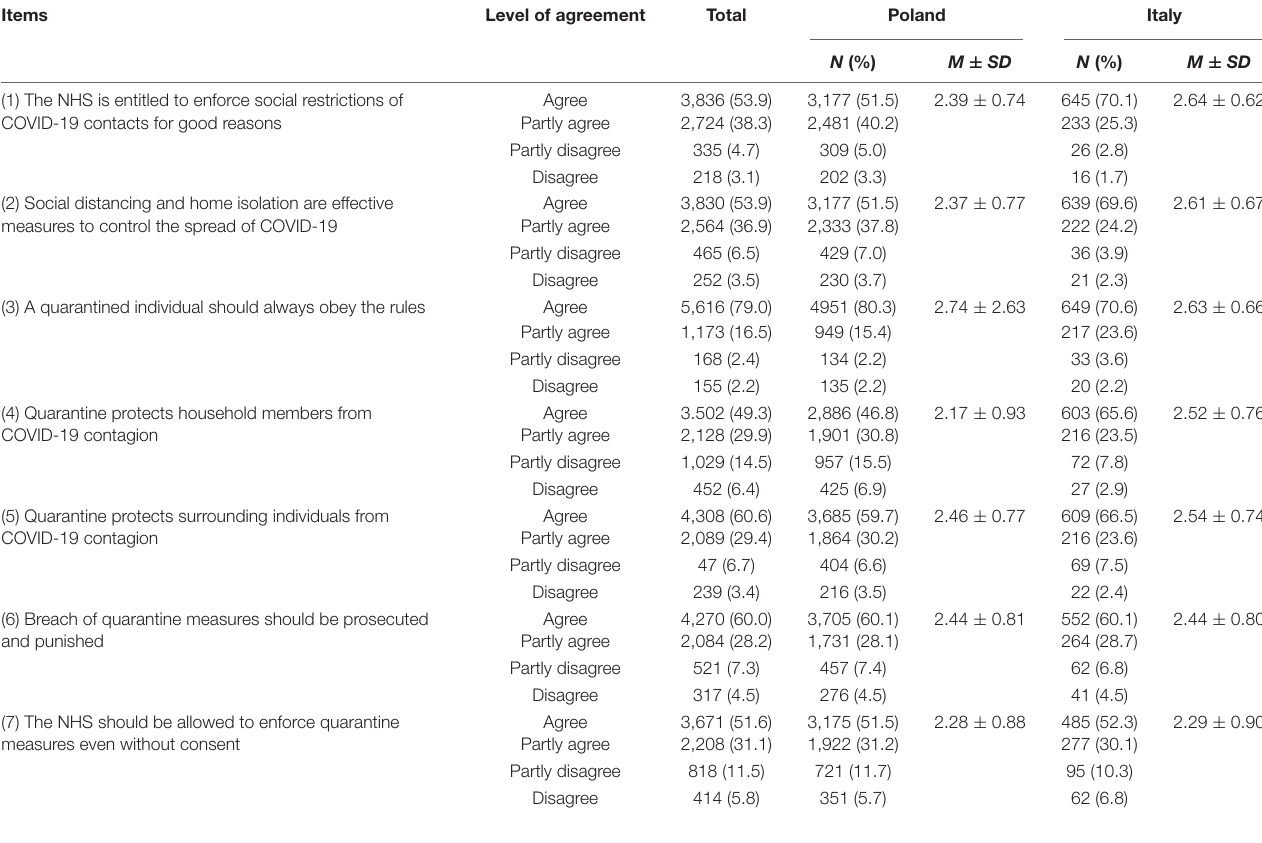
TABLE 3 | Attitudes/perceptions on health protection measures against the spread of COVID-19 by level of agreement and country of residence (Number, N and percentage, %); and Health Protection Attitude Score (Mean, M ± standard deviation, SD) by